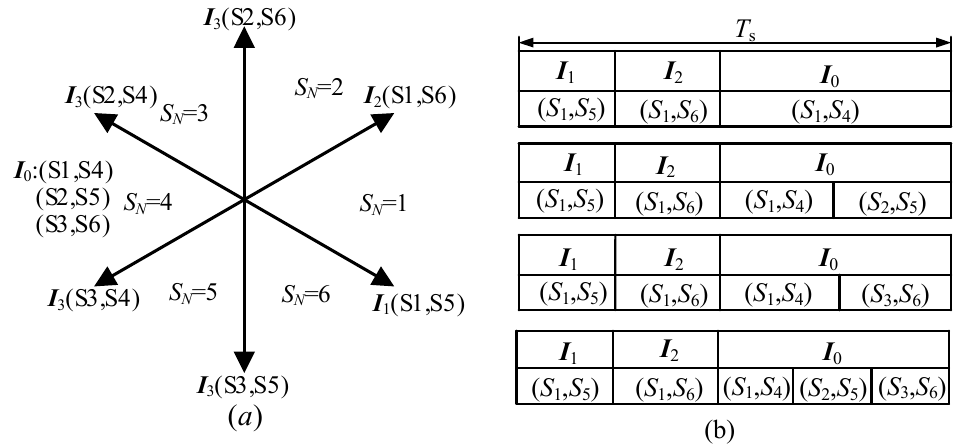
Figure 4. Switching sequence in the rectifier side for sector 1: ( a ) definition of current vectors; ( b ) switching sequence for sector 1.